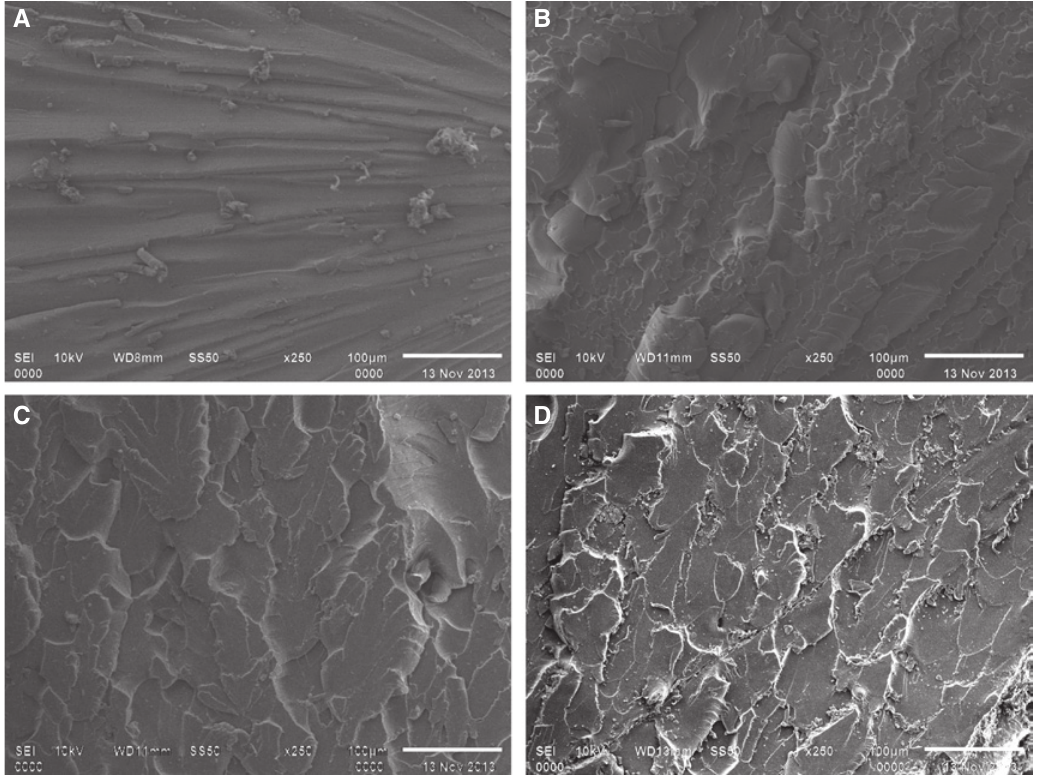
Figure 1 SEM images of fracture surface for several cured epoxy: (A) pure epoxy, (B) 0.5 wt% rubber, (C) 1.0 wt% rubber, (D) 1.5 wt%